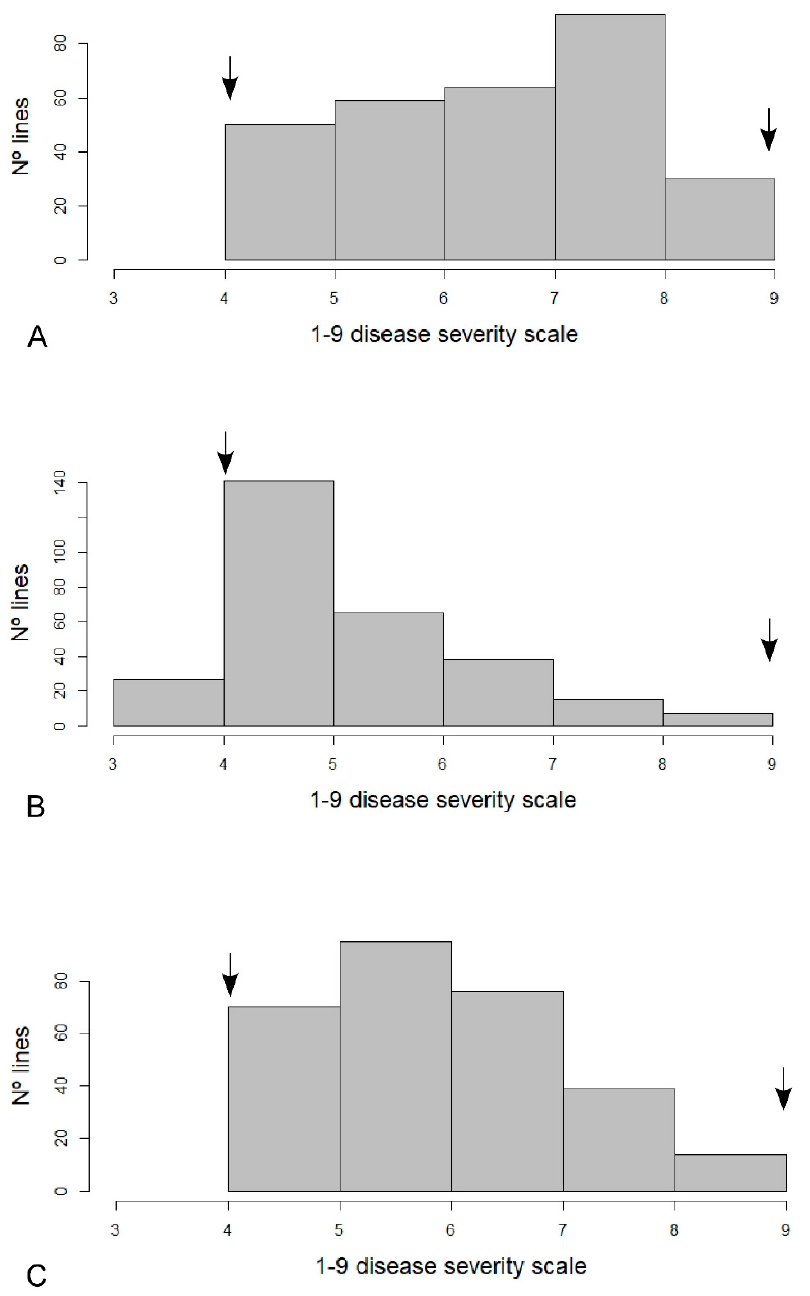
Figure 1. Histogram showing the distribution of the reaction against a local Sclerotinia sclerotiorum isolate in the 294 lines of the SDP (Spanish Diversity Panel) and the ( A ) E1, ( B ) E2, ( C ) Em. Arrows indicate the average value in the disease severity scale of resistant and susceptible checks.